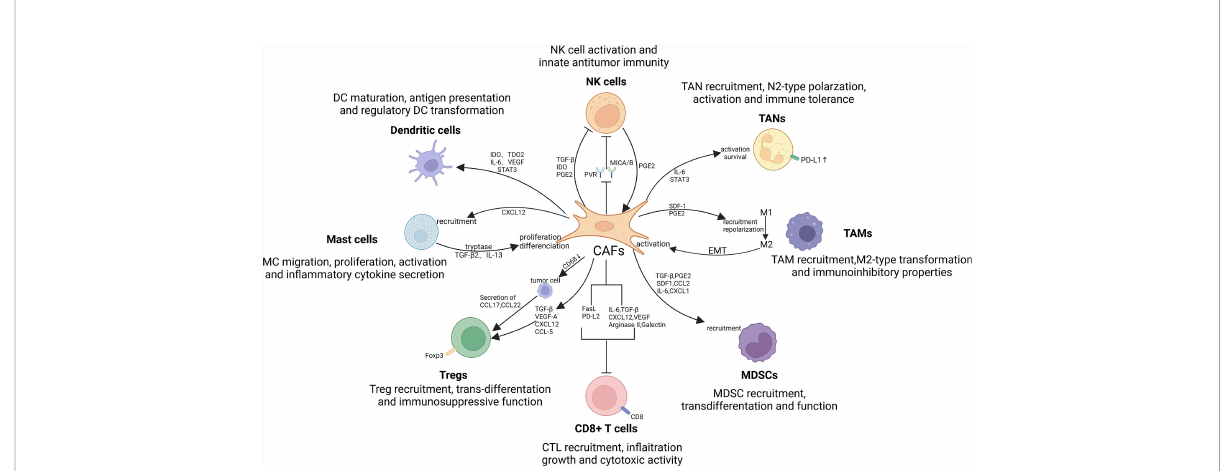
FIGURE 4 Crosstalk between CAFs and immune cells in the TIME. There exist signi fi cant interactions between CAFs and immune cells, such as tumor- associated macrophages (TAMs), tumor-associated neutrophils (TANs), mast cells (MCs), dendritic cells (DCs), myeloid-derived suppressor cells (MDSCs), natural killer (NK) cells and T lymphocytes. By secreting cytokines, chemokines, and other effector molecules, including TGF- b , CCL2, CXCL2, laminin, and MMP, CAFs can promote the involvement of immune cells in tumorigenesis and progression. Notably, TAMs, NK cells and MCs can in turn exert promoting effect on CAFs activation and function, thereby contributing to the formation of immune suppressive